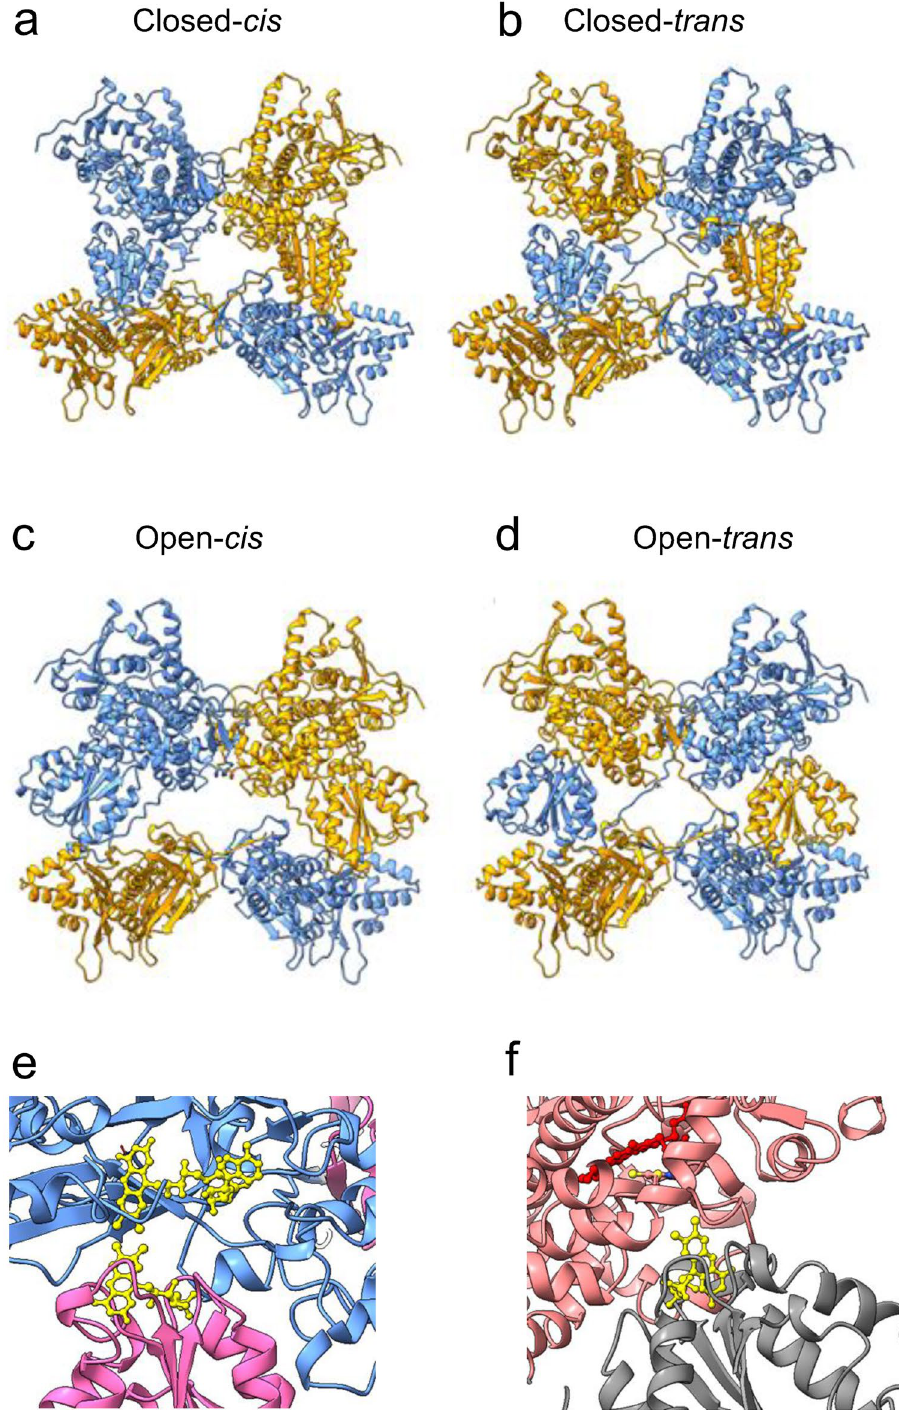
Figure 4. Predicted assembled structures for the open and closed conformations of a pair of full length CY102A1. ( a–b ), In the closed conformations, FMNd forms electron transfer competent complex with FADd. ( c–d ), In the open conformations, FMNd forms electron transfer competent complexes with P450d; cis and trans refers, respectively, to non-crossed and crossed topologies of the P450d-FMNd linker. In the open conformation, the linker between FMNd and FADd is not represented (see “Methods” section). The two AF2A- predicted chains in the dimer are colored differently for the sake of clarity. ( e–f ), Geometries of cofactors in the closed (FMN and FAD in e ) and open conformations (FMN and heme in f ). Flavins are colored yellow and heme colored